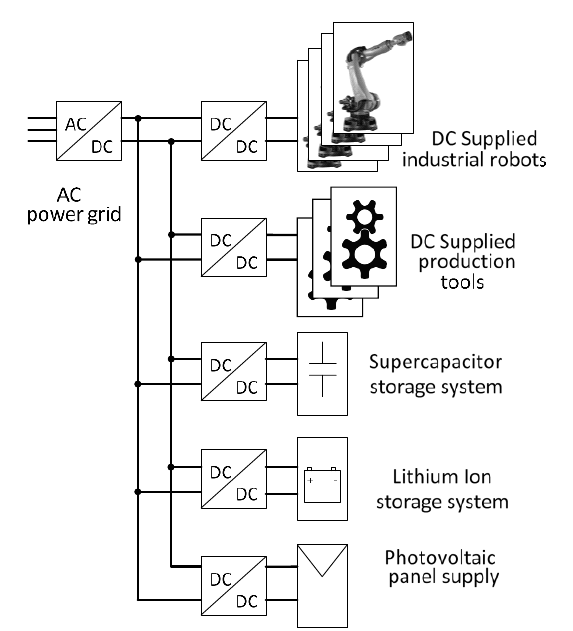
Fig. 2. Example of industrial DC microgrid